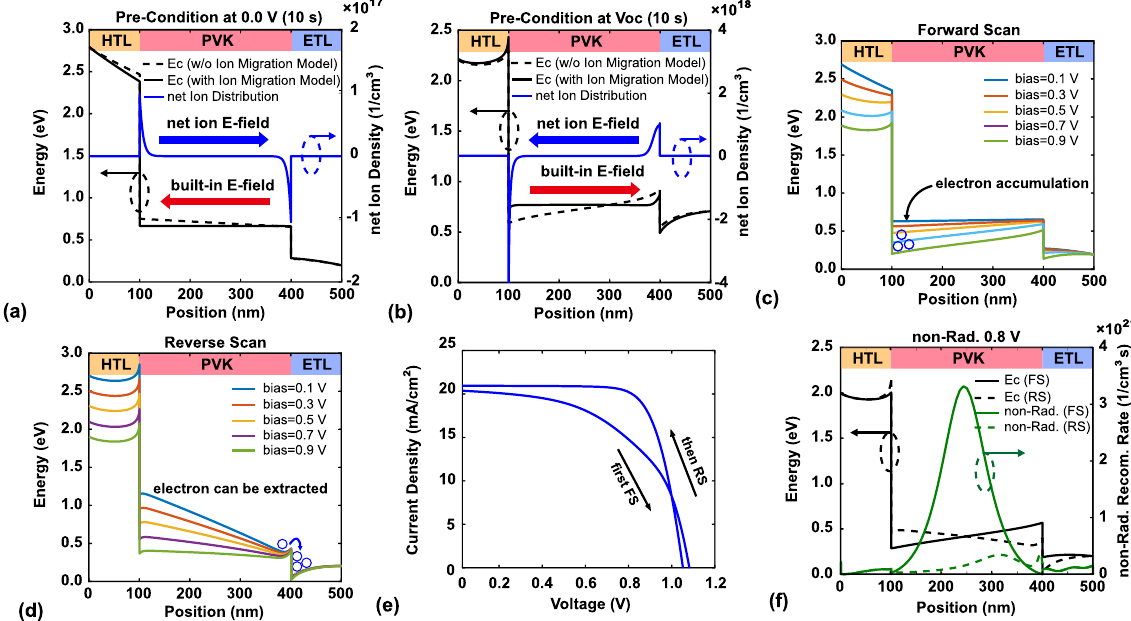
Figure 1. ( a ) and ( b ) are band diagram and net ion distribution for preconditioning at 0 V and V oc , respectively. ( c , d ) Changes in the band diagram when bias is applied under forward and reverse scanning conditions, respectively. ( e ) J – V characteristics under forward and reverse scanning conditions. ( f ) Band diagram and non-radiative recombination rate under forward and reverse scanning conditions at a bias of 0.8